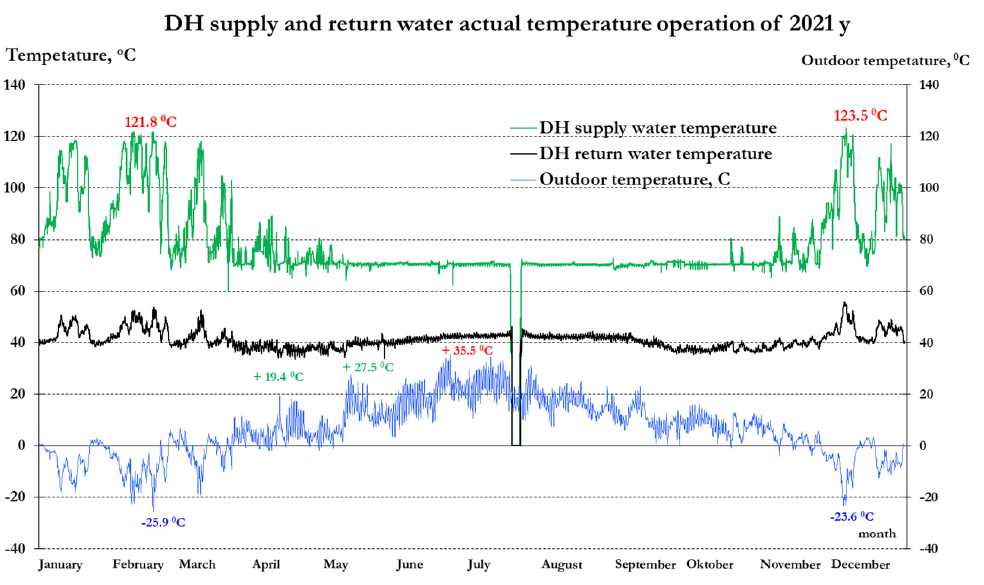
Figure 4. Actual supply and return water temperatures for the Narva district heating system in 2021.